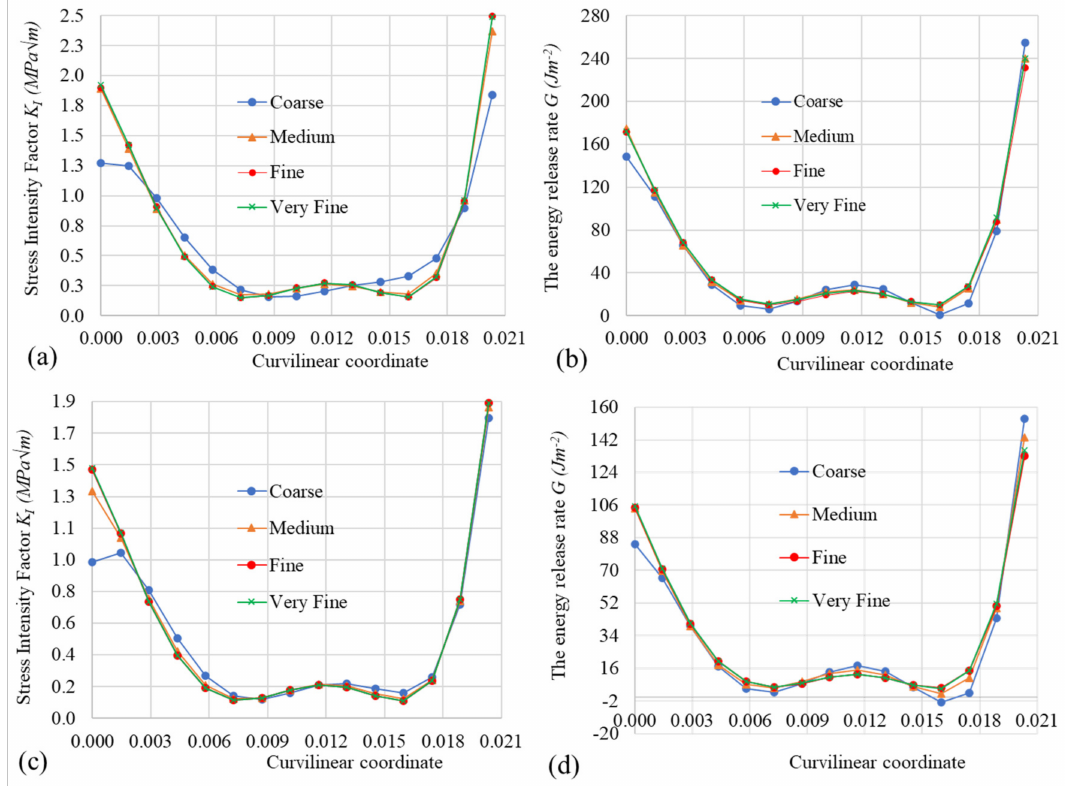
Figure 7. Mesh size effect on the values of K I and of G versus the curvilinear coordinate along the crack tip—the tibia model without the implant ( a , b ) and the tibia model with the implant ( c , d